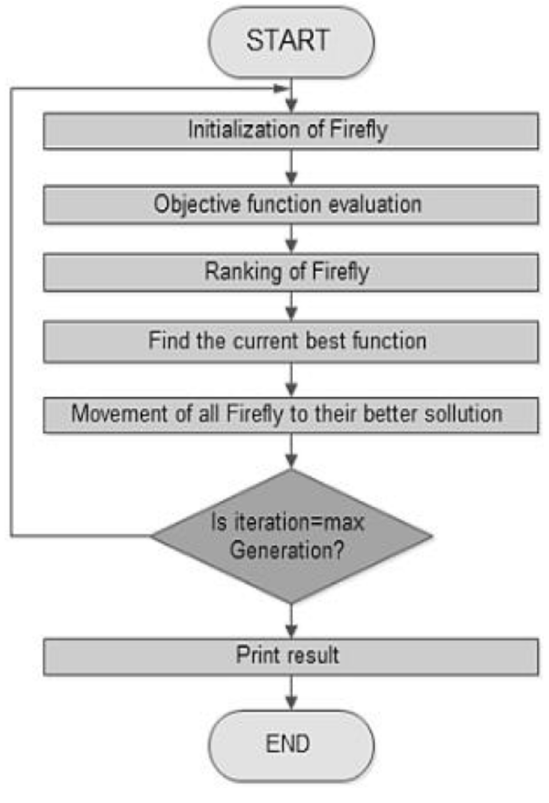
Fig. 5. Fire fl y algorithm [22].